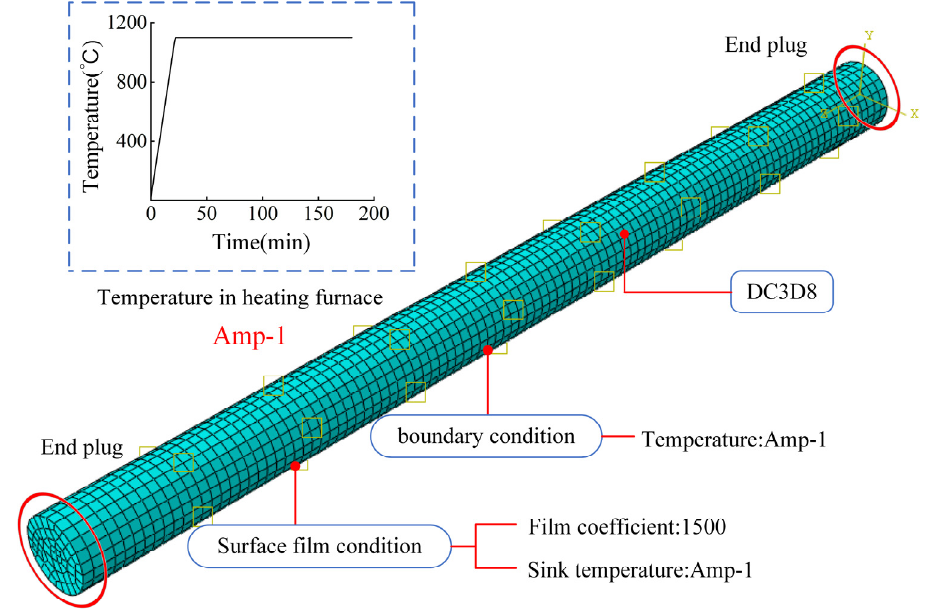
Figure 14. Finite element model.